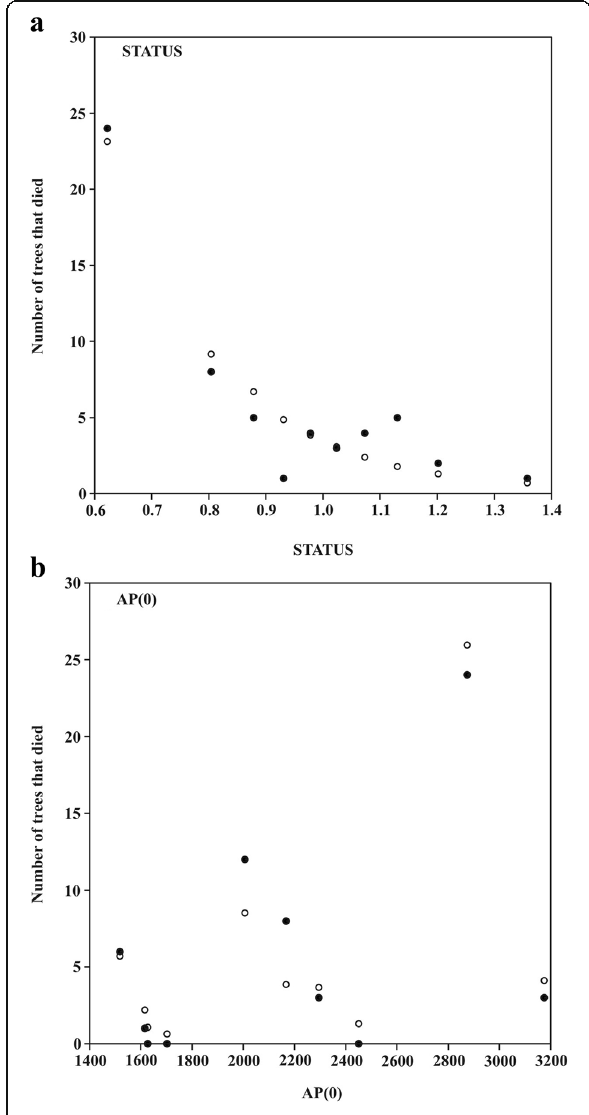
Fig. 2 Predicted circle ( ○ ) and actual dot ( (cid:129) ) number of trees that died by decile of the variables STATUS ( a ) and AP(0) ( b